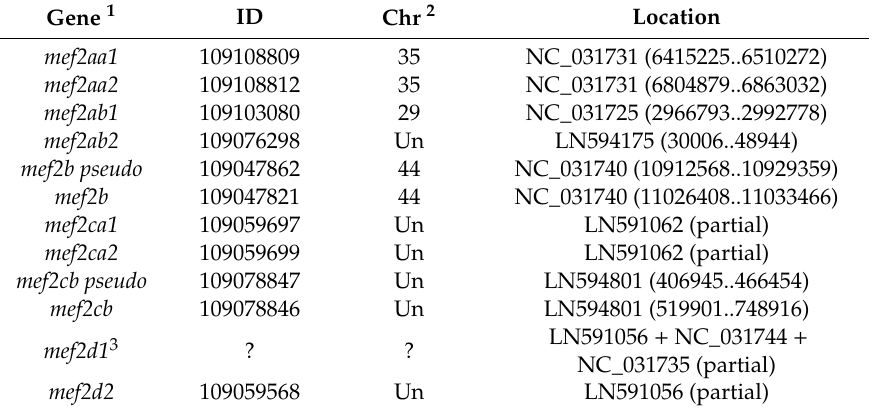
Table 2. Predicted mef2 genes in Cyprinus